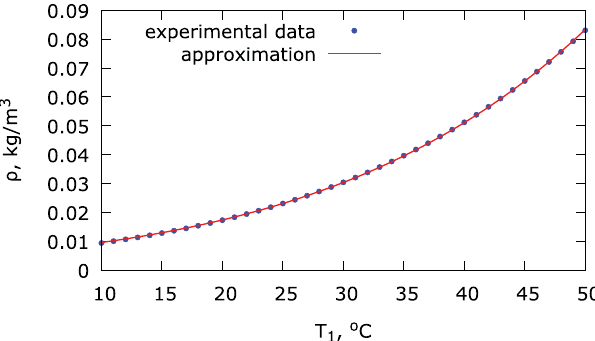
Fig. 3. Experimental relation between the temperature and the density of the saturated water vapour [8], approximated by equation